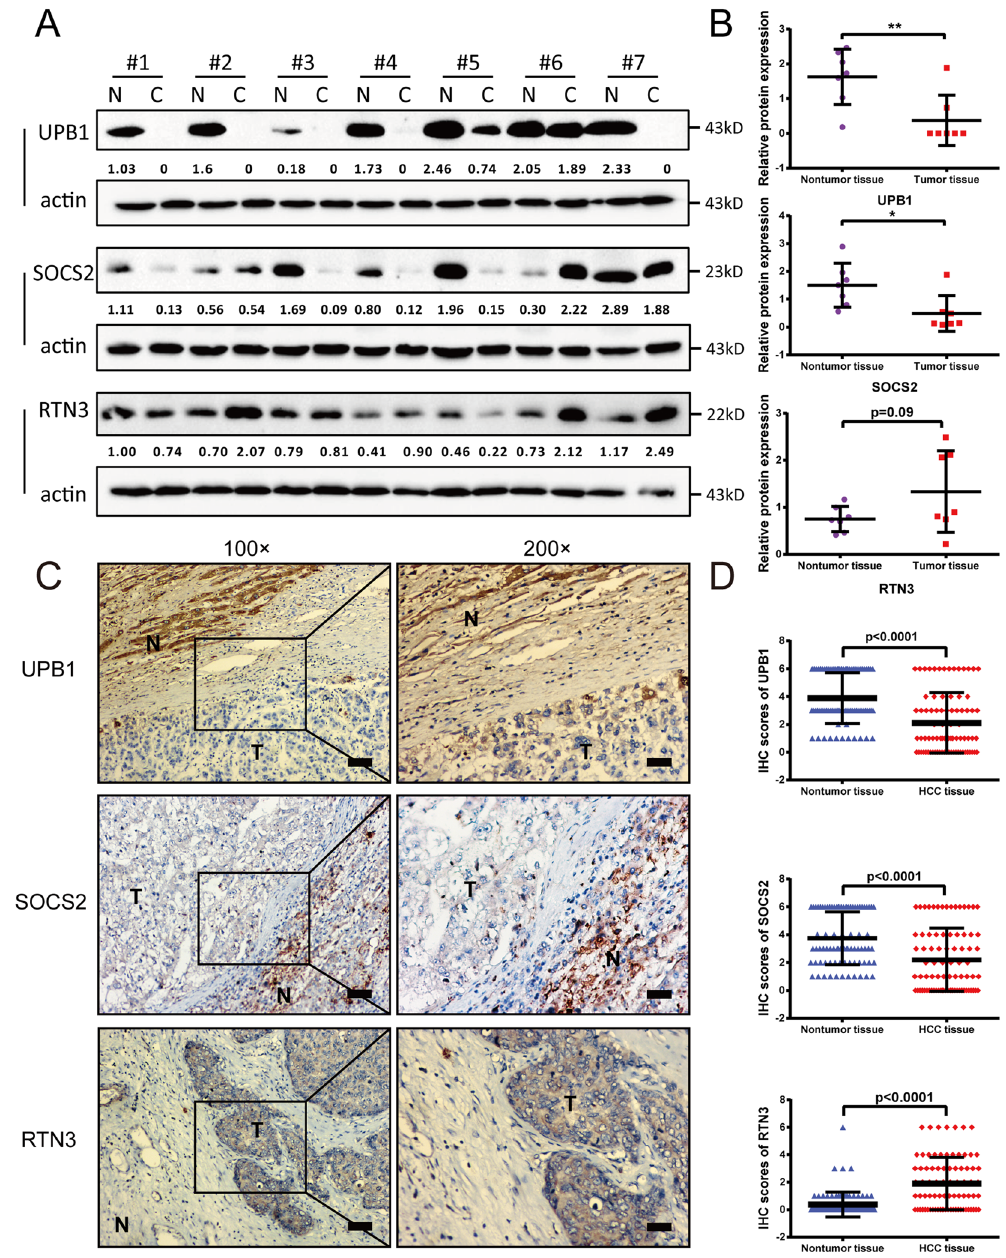
Figure 4. Validation the expression pattern of prognostic genes in HCC samples. ( A ) Western blot analysis of UPB1 (upper panel), SOCS2 (middle panel), and RTN3 (lower panel) in 7 paired normal and tumor tissue samples. ( B ) Western blot quantitative densitometry of the UPB1, SOCS2, and RTN3 relative expressions. Proteins was quantified and normalized to β -actin. Statistical analysis was done using Wilcoxon rank test. Data are expressed as mean values ± SD. * p < 0.05, ** p < 0.01. ( C ) Representative images from immunohistochemistry (IHC) staining of UPB1 (upper panel), SOCS2 (middle panel), and RTN3 (lower panel) in 82 normal tissues and paired HCC tissues. Left panel: 100 × magnifications; right panel: 200 × magnifications. Bars = 100 μ m. ( D ) Statistical analyses of the average IHC scores of UPB1 (upper panel), SOCS2 (middle panel), and RTN3 (lower panel). Statistical analysis was done using Wilcoxon rank test. Data are expressed as mean values ±